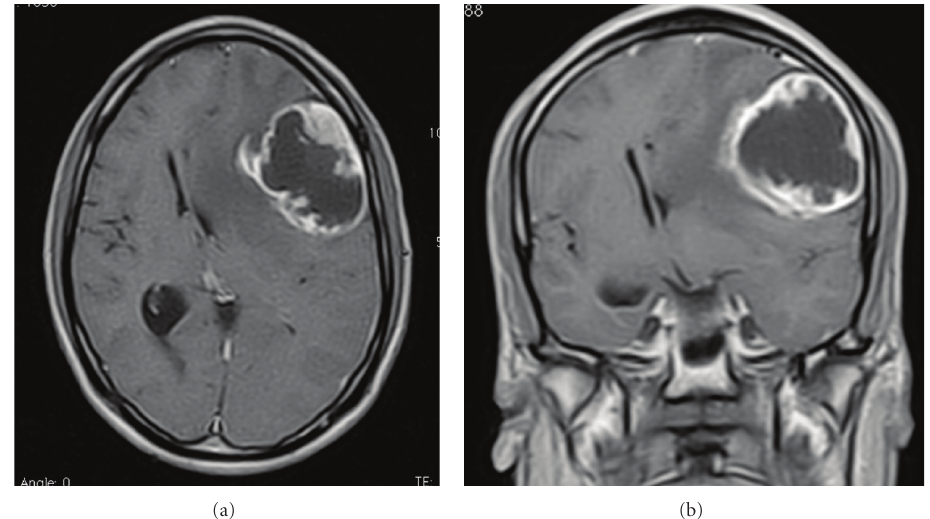
Figure 1: Preoperative MRI in axial (a) and coronal (b) view, showing extraventricular intraxial extensive